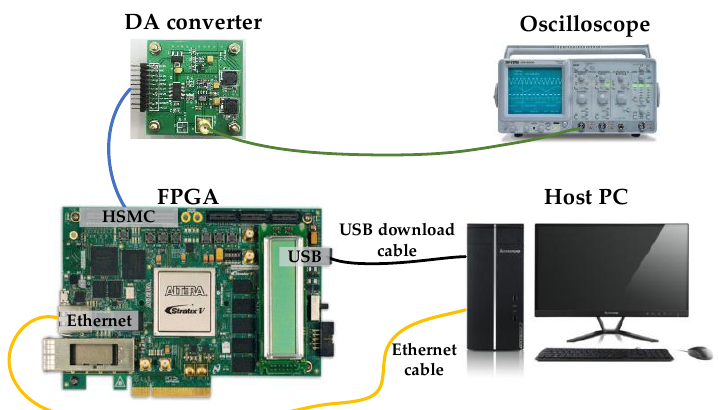
Figure 6. The FPGA-based real-time simulator for active distribution networks.